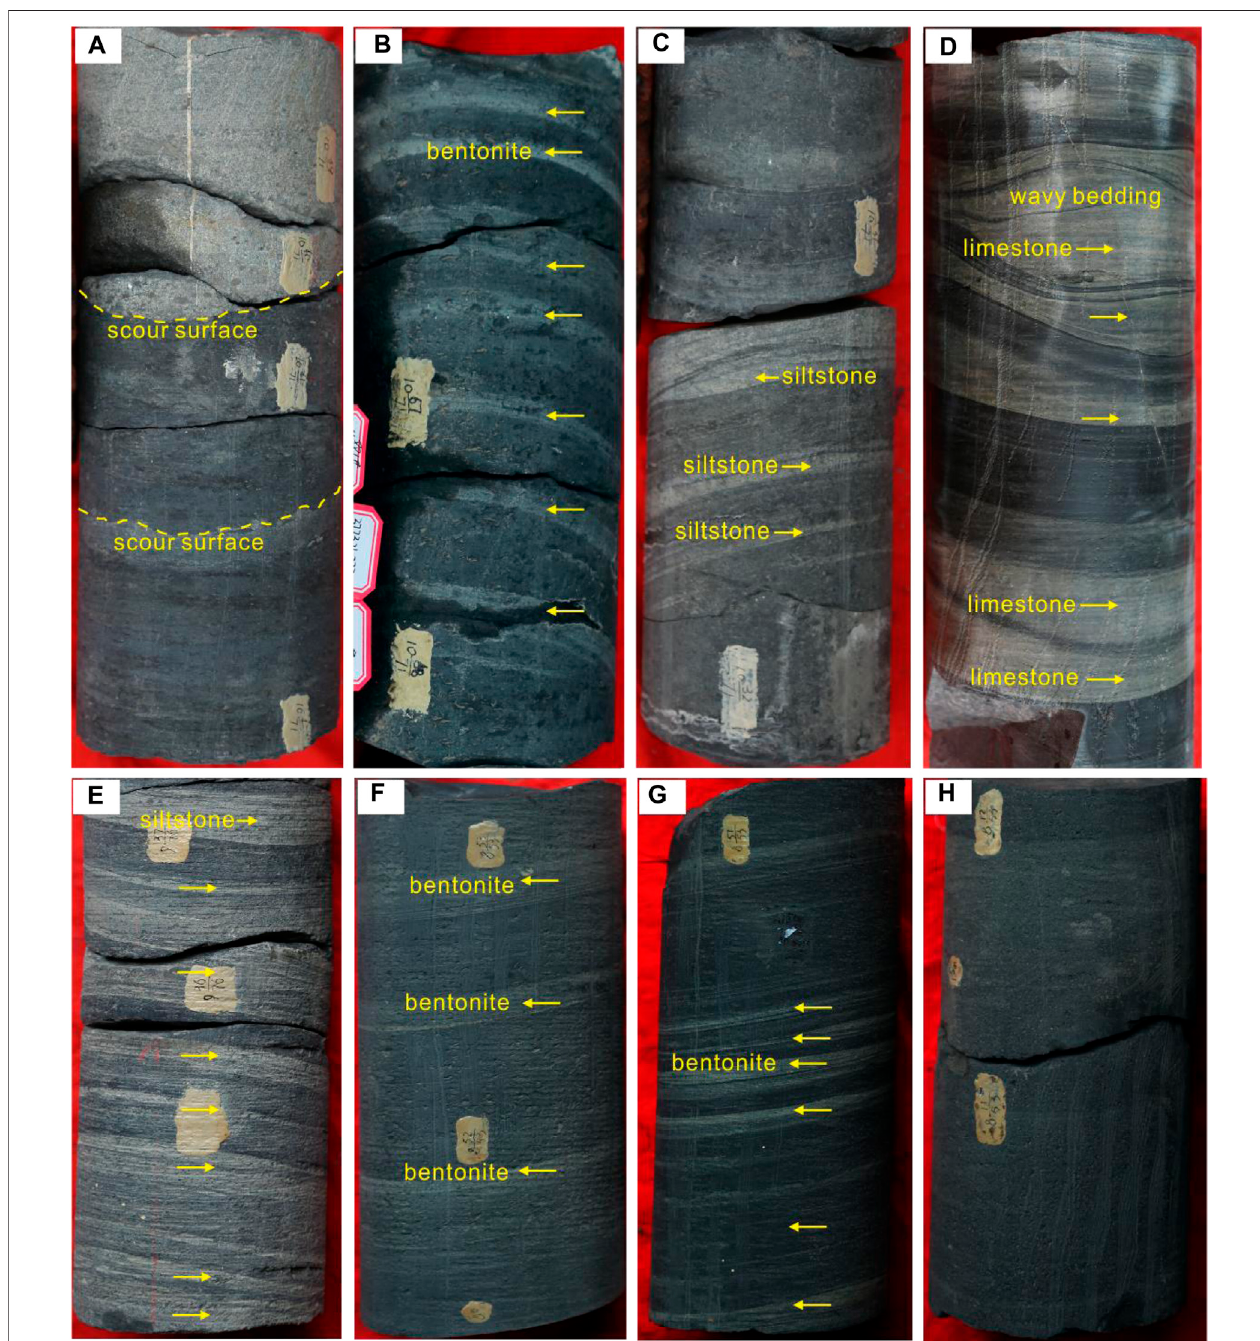
FIGURE 3 | Macroscopic sedimentary characteristics for Linghao Formation from the studied well in the central Nanpanjiang basin. (A) Scour surface between black shale and gravity fl ow sandstone, lower Ling 1 member, 3,803 m – 3803.23 m. (B) Frequent thin interbeds of bentonite in black shale, upper Ling 1 member, 3,772.88 m – 3773.21 m. (C) Frequent thin interbeds of siltstone, Ling 2 ember, 3,558.63 m – 3559.19 m. (D) Frequent thin interbeds of limestone and wavy bedding, Ling2Member,3,738.13 m – 3738.42 m. (E) Frequentthininterbedsofsiltstoneinmudstone,Ling2Member,3,559.57 m – 3559.92 m. (F) Frequentthininterbeds of bentonite, lower Ling 3 Member, 3,414.91 m – 3415.22 m. (G) Frequent thin interbeds of bentonite, lower Ling 3 Member, 3,414.62 m – 3414.91 m. (H) Black shale with massive bedding, lower Ling 3 Member, 3,412.12 m – 3412.30 m.